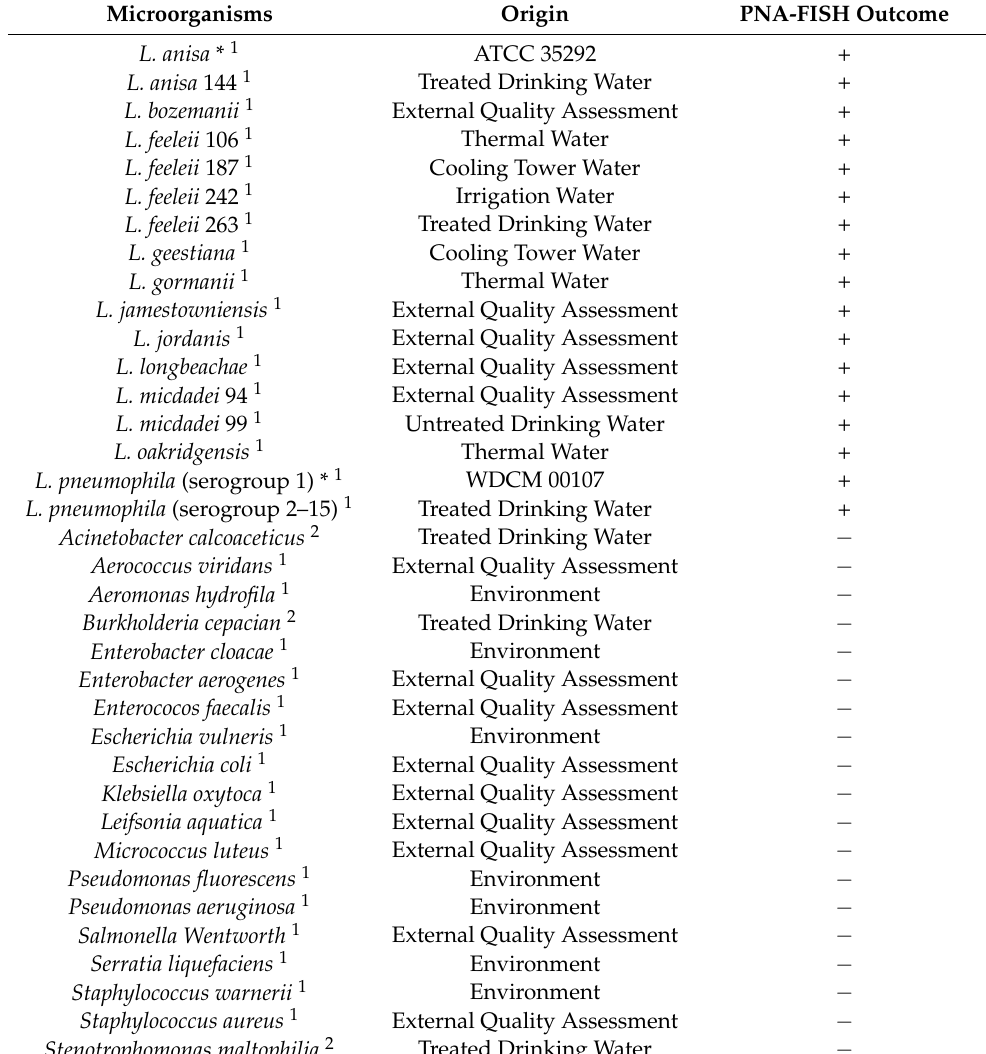
Table 1. List of strains used in this study, together with the results obtained with the PNA-FISH probe specificity/sensitivity test. ATCC—American Type Culture Collection; WDCM—World Data Centre for